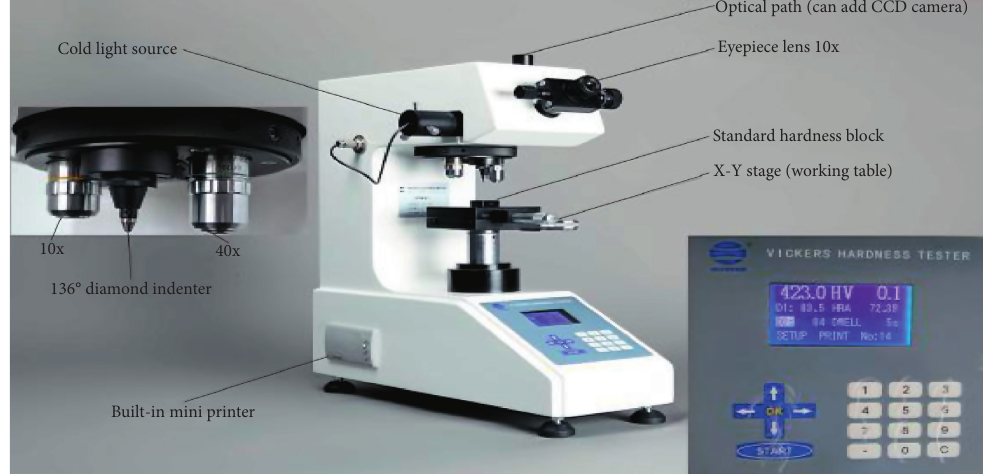
Figure 6: HVD-1000 MP micro-Vicker hardness tester.